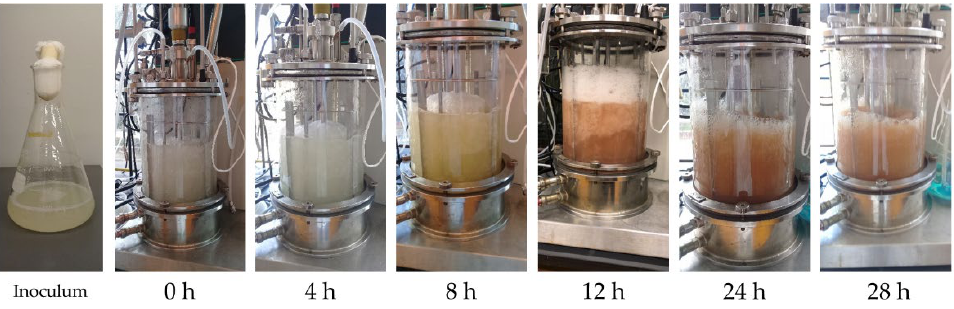
Figure A8. Pictures of culture #1 at different times of the fermentation process.